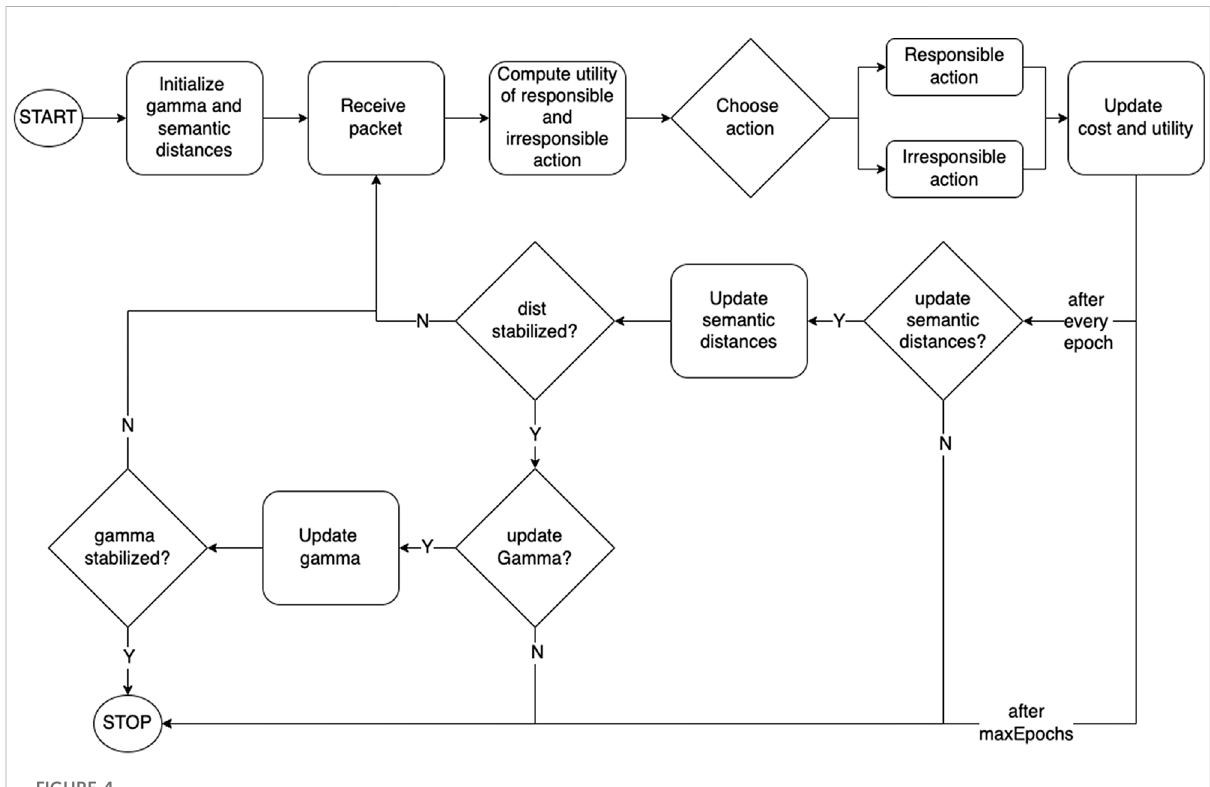
FIGURE 4 Block Diagram of a Transcended